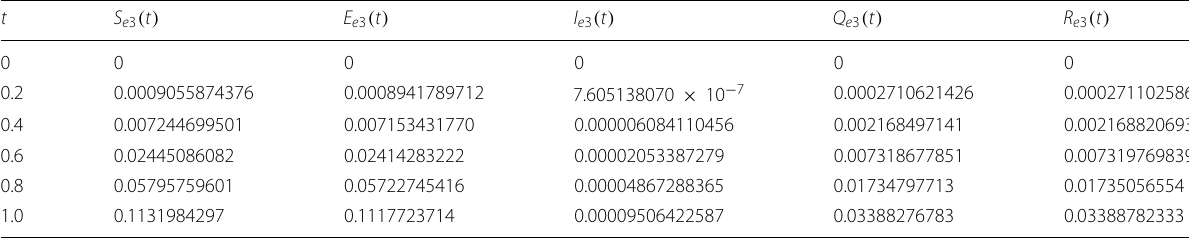
Table 4 Third-order maximum truncation error for t ∈ [ 0,1 ]